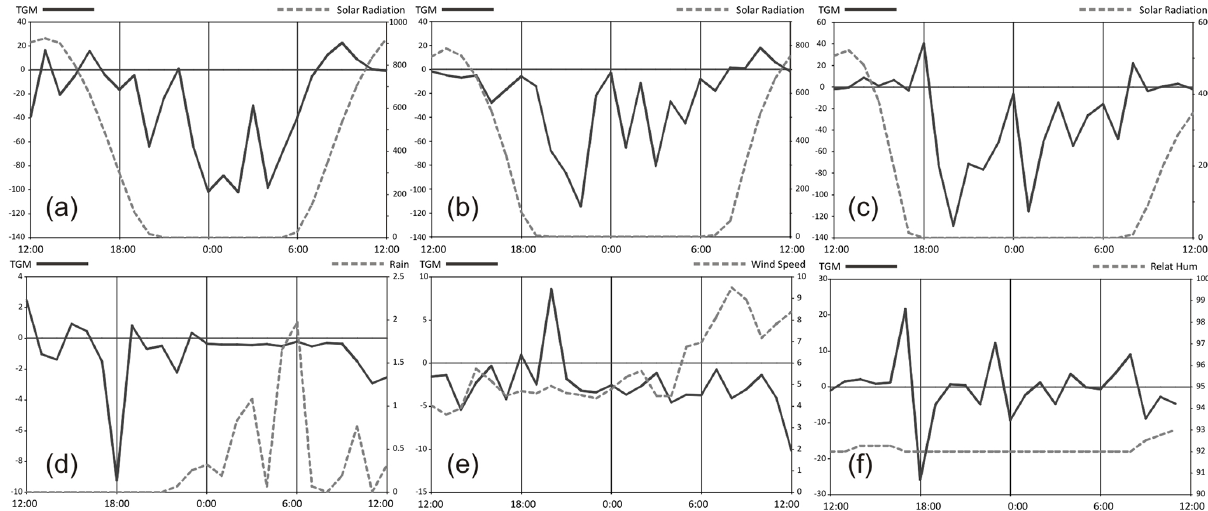
Figure 4. Evolution of TGM total gradients during typical contrasting meteorological conditions: (a) typical summer day; (b) typical winter day; (c) thermal inversion day; (d) rainy day; (e) windy day; and (f) foggy day.